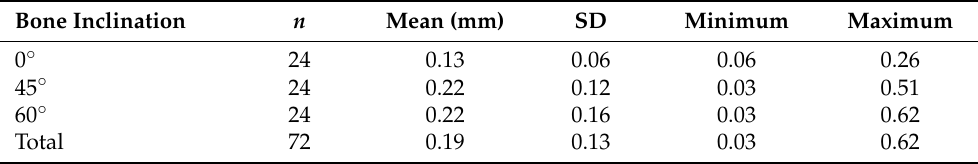
Table 12. Results of descriptive statistics of vertical linear deviation in varying bone